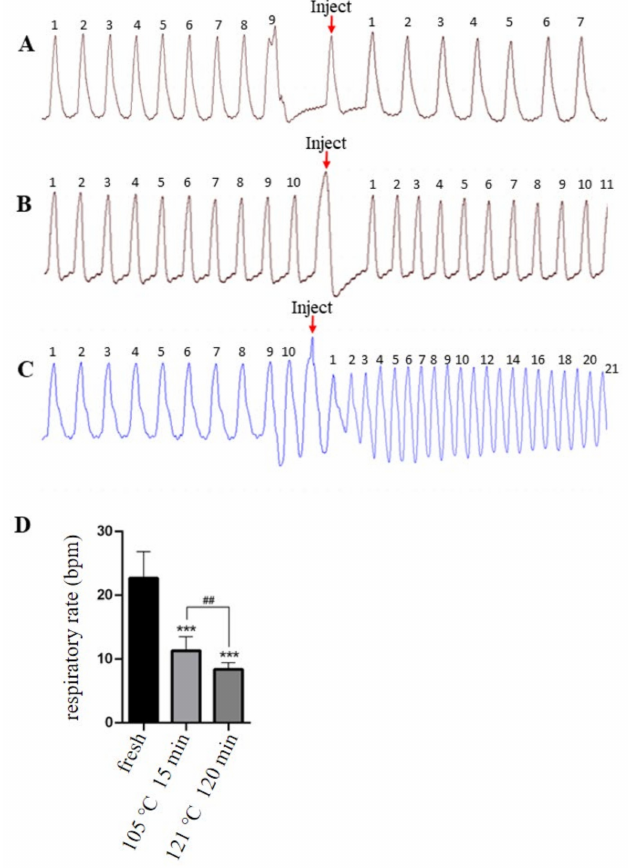
Figure 3. Effects of lobeline injection with different isomerization levels on excited respiration in rats with respiratory depression. ( A ): treated at 121 ◦ C for 120 min, ( B ): treated at 105 ◦ C for 15 min, ( C ): fresh, ( D ): respiration rate. “***” represents compared with the Fresh group, p ≤ 0.001, “ ## ” represents compared with the 105 ◦ C 15 min group, p ≤